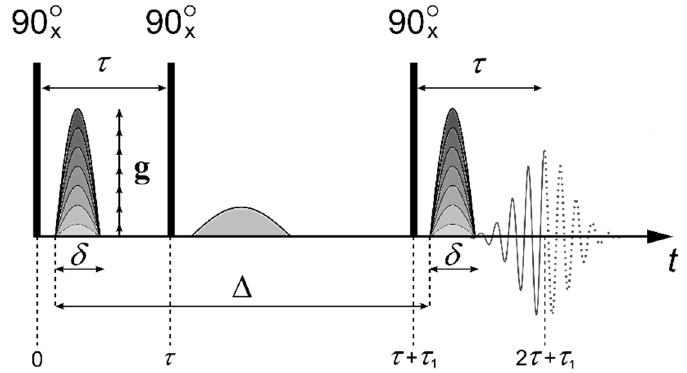
Figure 12. Stimulated echo pulse sequence with the magnetic field gradient pulses. Here, τ is the time interval between the first and the second RF pulses, and τ 1 is the time interval between the second and the third ones. D is the interval between the gradient pulses, δ is the duration of the equivalent rectangular magnetic field gradient pulses, g is the amplitude of the magnetic field gradient pulse, and g 0 is the amplitude of the constant magnetic field gradient. Reprinted with permission from Ref. [44].